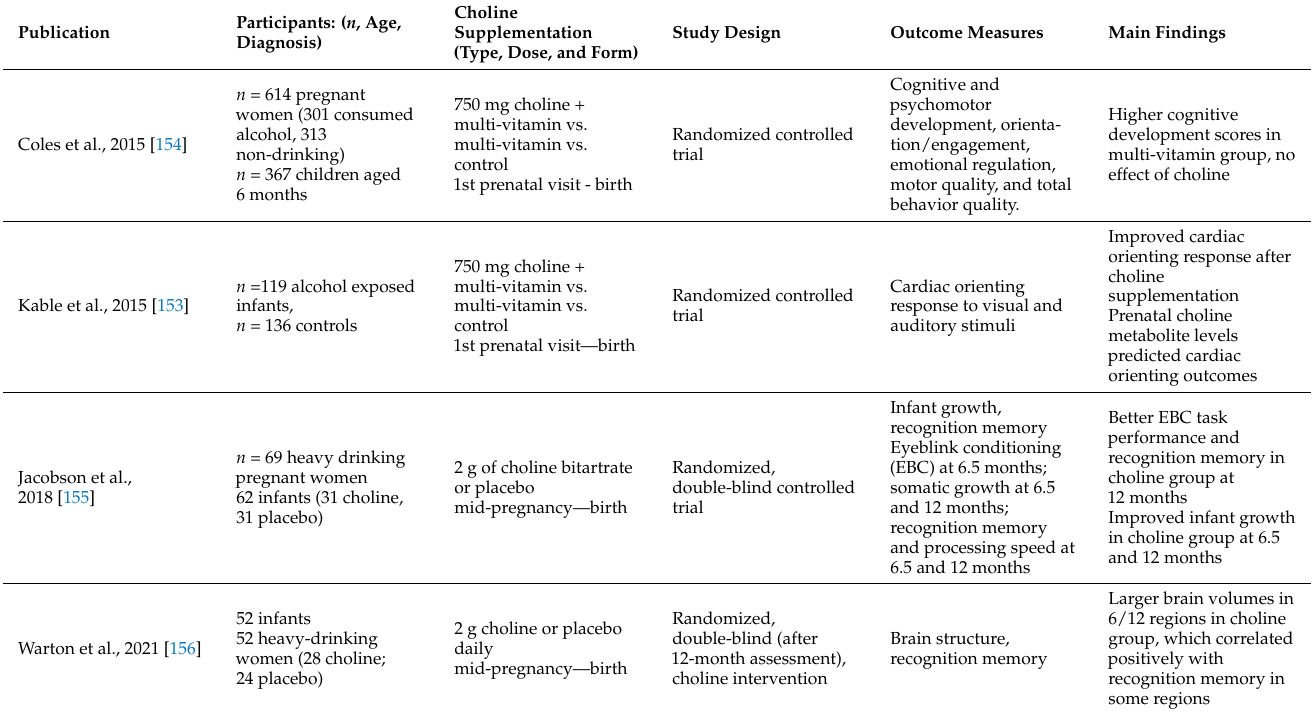
Table 1. Summary of prenatal choline supplementation